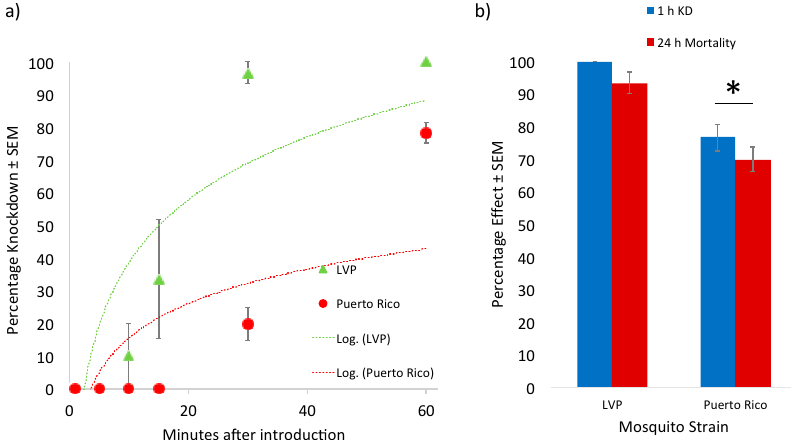
Figure 1. Knockdown response of Aedes aegypti strains exposed to a discrete dose of permethrin. ( a ) Puerto Rico strain displayed lower percentage knockdown than the Liverpool strain at all time points screened in this study. ( b ) Puerto Rico strain also displayed less percentage knockdown 1 h after removal from the exposure chamber and 24 h percentage mortality than the Liverpool strain.